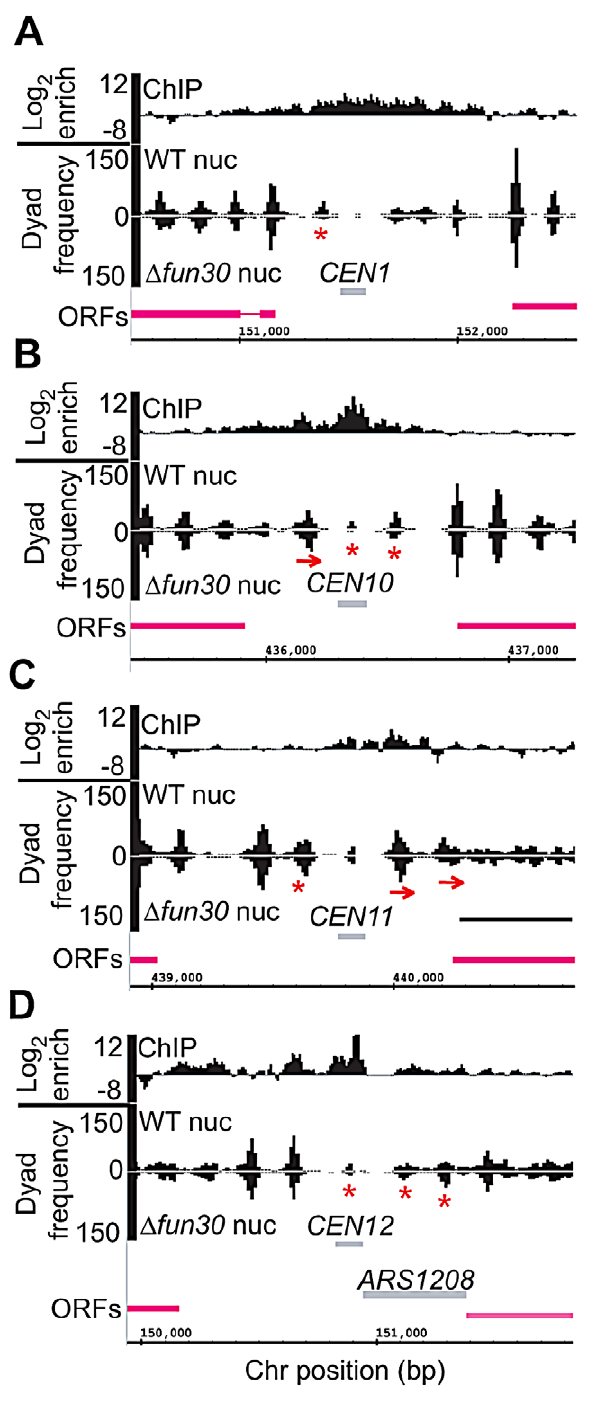
Figure 8. Fun30 is required for normal CEN -flanking nucleo- some positioning and/or CEN core particle structure. A) Genome browser trace of Fun30 ChIP enrichment and nucleosome dyad frequency centred on and surrounding yeast CEN1 . The upper trace shows Log 2 Fun30 ChIP-seq enrichment values binned at 10 bp intervals and smoothed with a 3 bin moving average. Wildtype (WT) and D fun30 chromatin was digested with MNase and nuclease- protected DNA species sequenced using paired-end mode Illumina technology. Nucleosome sequencing data (nuc) traces were plotted as mirror images in the lower panel. The graph shows a map of the centre point positions of paired sequence reads with end-to-end distances of 150 bp + / 2 20% wild-type and D fun30 mutant chromatin